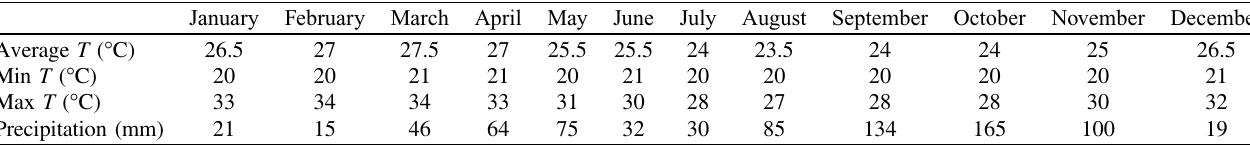
Table 2. Monthly average temperature and precipitation/rainfall of 2017 in Yaoundé.